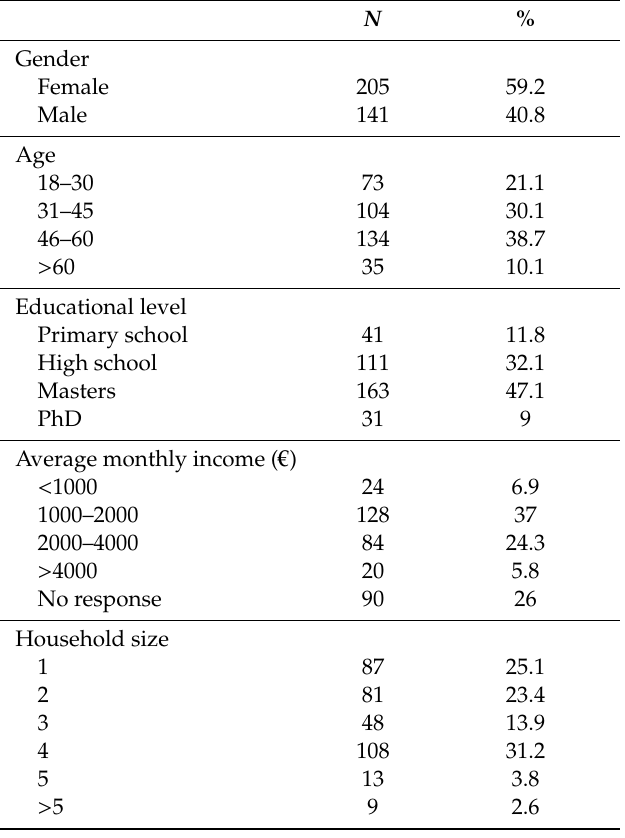
Table 1. Respondents’ socio-demographic characteristics ( N =